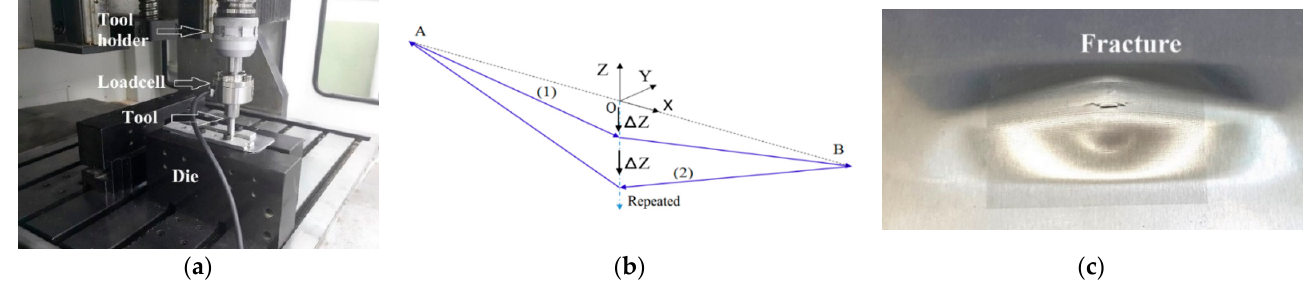
Figure 3. ( a ) Forming set up for incremental sheet forming. ( b ) Two-wing star toolpath. ( c ) Fracture happening for the two-wing star toolpath (bottom-up view).